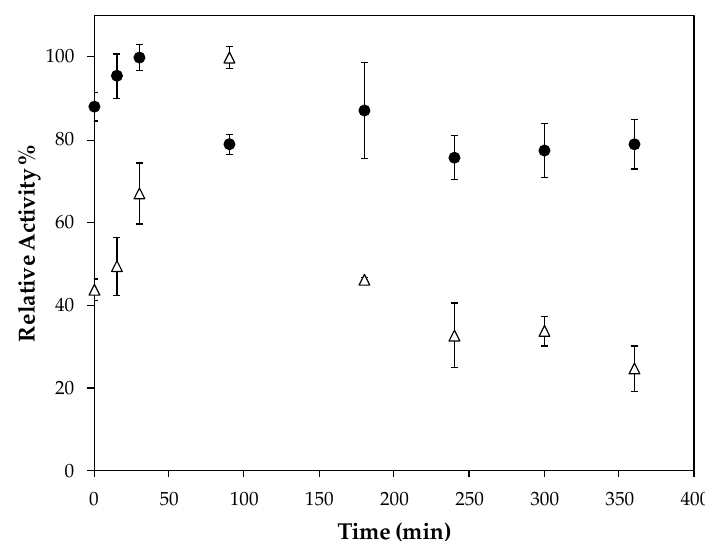
Figure 5. Stability of microcapsules obtained in optimal conditions (3.1 %, chitosan concentration of 0.2 %, calcium chloride concentration of 0.14 M, and complexation time of 1 min) (●) and free enzyme (LipEE—∆) in hydrolysis reaction with p -nitrophenyl laurate at 37 °C, pH 7.0. The enzymatic activity of the highest value for each biocatalyst was set to 100%.